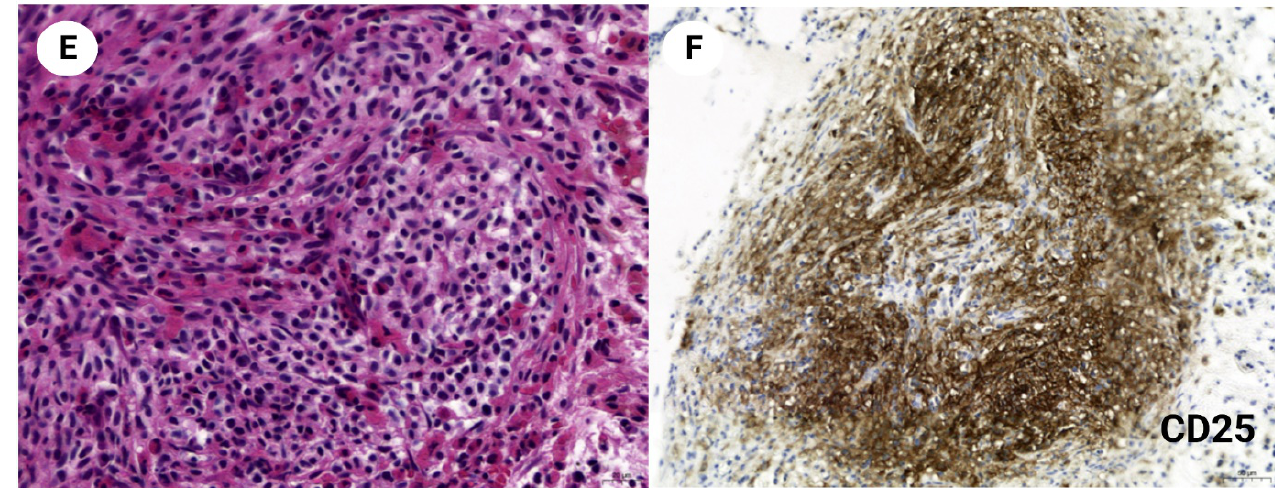
Figure 2. The patient has multiple purpuric telangiectases around the neck skin ( A ). Mast cells with basophilic cytoplasmic granules are increased in the upper dermis of the lesion ( B , H&E stain, × 400). C-Kit immunohistochemical stain highlights the infiltrating mast cells ( C , × 200). In the bone marrow, multifocal compact aggregates of masts cells with paratrabecular and interstitial distributions are seen ( D , H&E stain × 35). The abnormal mast cells contain spindle-shaped nuclei and clear cytoplasm and are associated with thin sclerotic fibers ( E , H&E stain, × 400). CD25, which is not expressed in normal mast cells, is positive in these abnormal mast cells ( F , × 200). A 64-year-old female patient was referred to the internal medicine clinic with an incidentally found mild splenomegaly and lymphadenopathy in the abdominal cavity during a health examination. She complained of mild abdominal discomfort and had a history of tuberculosis and cholecystectomy. Laboratory testing revealed a white blood cell count of 5.05 × 10 9 /L with 26.3% eosinophils. Segmented neutrophils and lymphocytes were 39.4% and 30.1%, respectively. Hemoglobin was 11.1 g/dL, platelet count was 186 × 10 12 /L, and LDH was 90 U/L. Abdominal CT demonstrated lymphadenopathy along the entire abdominal cavity, especially in the mesenteric and paraaortic areas. They measured less than 0.7 cm in short diameter. Mesenteric lymph node excision was performed for the diagnosis. The lymph node revealed aggregates and infiltration of pale-staining cells, largely replacing interfollicular and sinusoidal spaces. Nodular aggregates of these cells resembled granuloma. They were accompanied by delicate sclerosis and numerous eosinophils (Figure 1A–D). Tumor cells expressed C-kit and tryptase (Figure 1E), but were negative for CD1a, langerin, S100, CD21, CD3, CD20, CD34, CD30, and myeloperoxidase. Toluidine blue stain showed scanty basophilic cytoplasmic granules (Figure 1F), but the granules were not apparent in the Giemsa stain. Accordingly, the diagnosis of systemic mastocytosis was favored. The subsequent physical examination discovered multiple purpuric telangiectases around the neck and chest skin (Figure 2A). The skin biopsy demonstrated mast cells with small basophilic granules infiltrating the upper dermis (Figure 2B). The bone marrow biopsy contained a nodular aggregate of atypical mast cells that were positive for CD25 and CD117, confirming the neoplastic nature of the mast cells (Figure 2D–F). Like the lymph node, abundant eosinophilic infiltration was prominent in the bone marrow. Cytogenetic analysis of the bone marrow revealed a normal female karyotype, and real- time PCR molecular studies showed a lack of BCR-ABL1 fusion, PDGFRa , and PDGFRb mutation. KIT gene harbored D816V mutation. Next-generation sequencing of the lymph node also demonstrated c.2447A>T p.(D816V) (VAF = 13.8%) mutation. The patient fulfilled the diagnostic criteria of systemic mastocytosis. It could be clinically subclassified as smoldering systemic mastocytosis because the patient had no C (‘cytoreduction-requiring’) findings and no evidence of an associated hematological neoplasm [1,2]. The patient is under watchful follow-up without active treatment and is stable one year after the diagnosis. Systemic mastocytosis is usually discovered initially in the bone marrow, and histology of the lymph node lesion is less familiar [3,4]. Lymphadenopathic mastocytosis with eosinophilia is a rare group of systemic mastocytosis that presents in ~10% of patients with